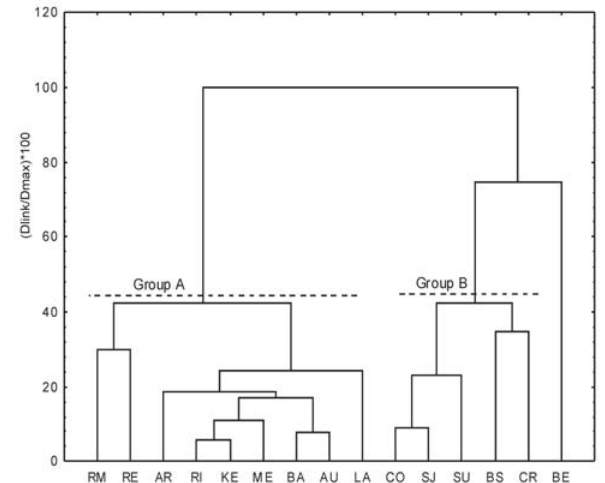
Fig. 3. Cluster dendrogram based on relative abundance in biomass of Cynodontidae species and water transparency from 15 sampling sites in the Bananal floodplain, Mato Grosso, Brazil (UPGMA algorithm, Euclidian distance). See Table 1 for site